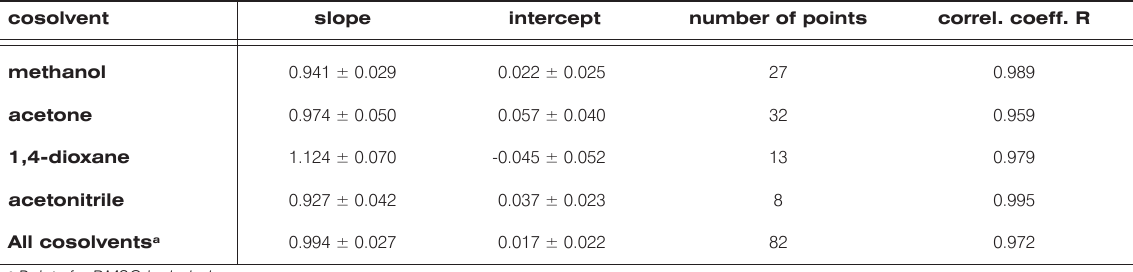
Table 2. Correlations of similarity coefficients for reactions in binary aqueous mixtures with those for reactions in water-ethanol mixtures.